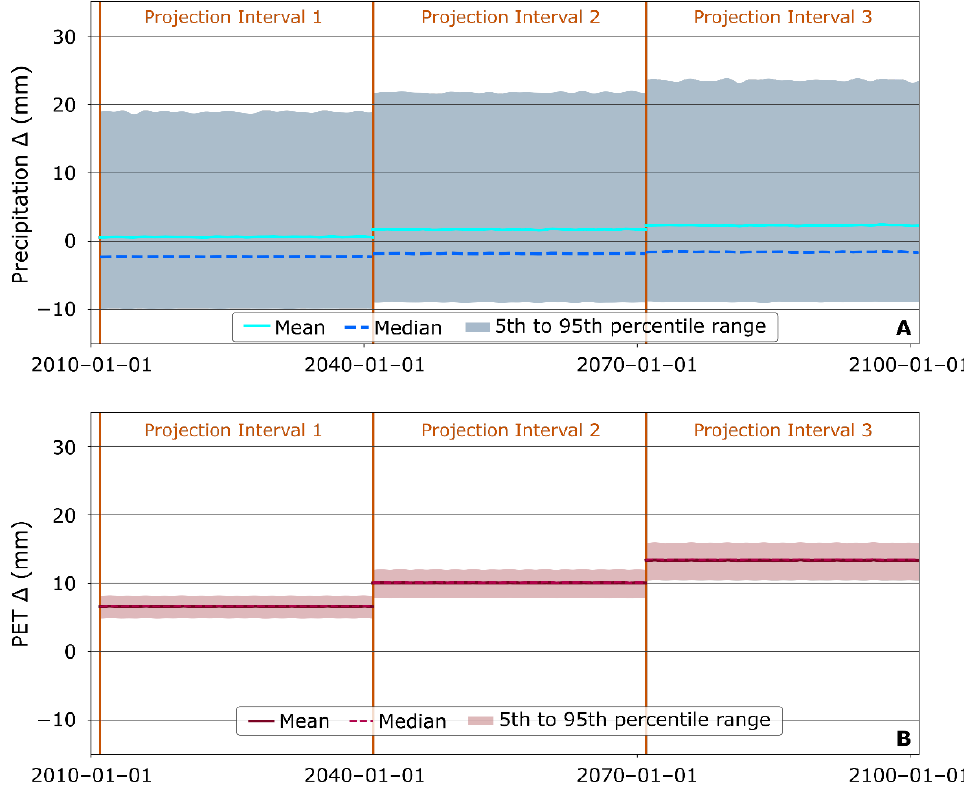
Figure 8. Calibrated weather generator precipitation and PET probabilistic Δ time histories. ( A ) Precipitation probabilistic Δ time histories show slight increases in precipitation on average due to climate trends. The 5th to 95th percentile range for precipitation Δ shows a positive skew. This positive bias is created by enforcing simulation of larger magnitude extreme events as part of hypothesized climate trends. ( B ) PET probabilistic Δ time histories demonstrate consistent PET increases due to the increasing temperature trend.